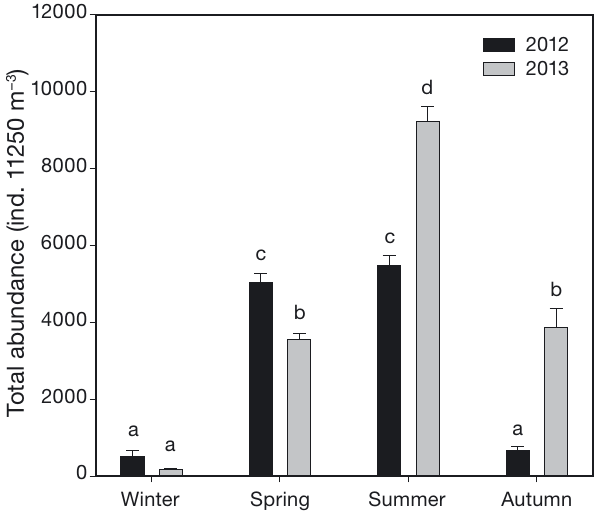
Fig. 2. Total abundance (mean ±SE) of wild fish (no. ind. 11250 m −3 ) aggregated around the studied fish farm during different seasons for 2 years. Different letters indicate sig- nificant differences between the levels of the Year × Season interaction (pairwise PERMANOVA; p <